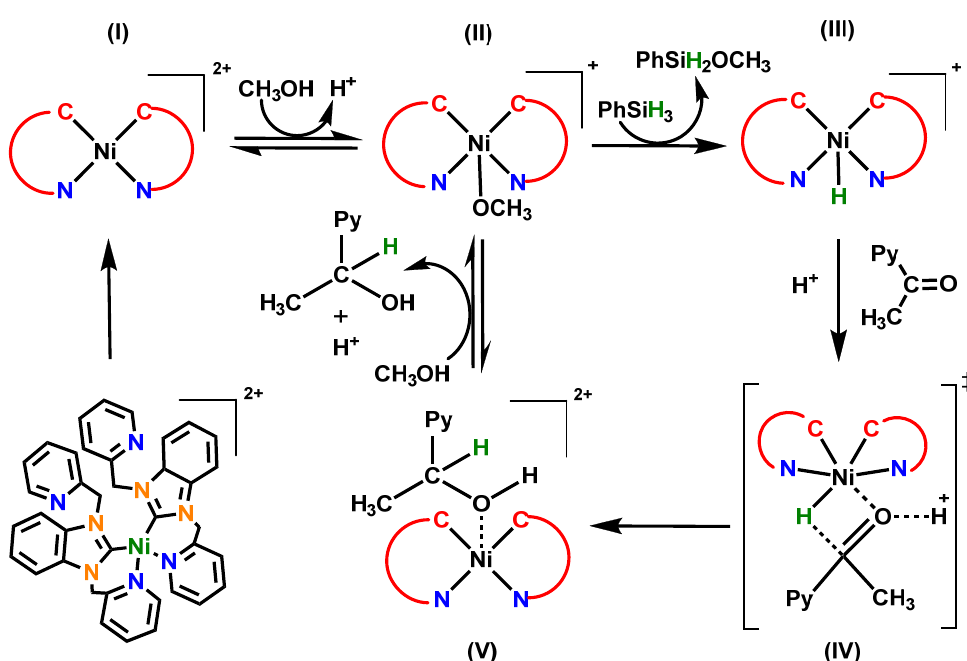
(Figure S7). ESI-MS (m/z): observed 677.21 for [M + H 2 O − 2PF 6 − ] 2+ ; calcd 677.23 for [M + H 2 O − 2PF 6 − ] 2+ (Figure S8).